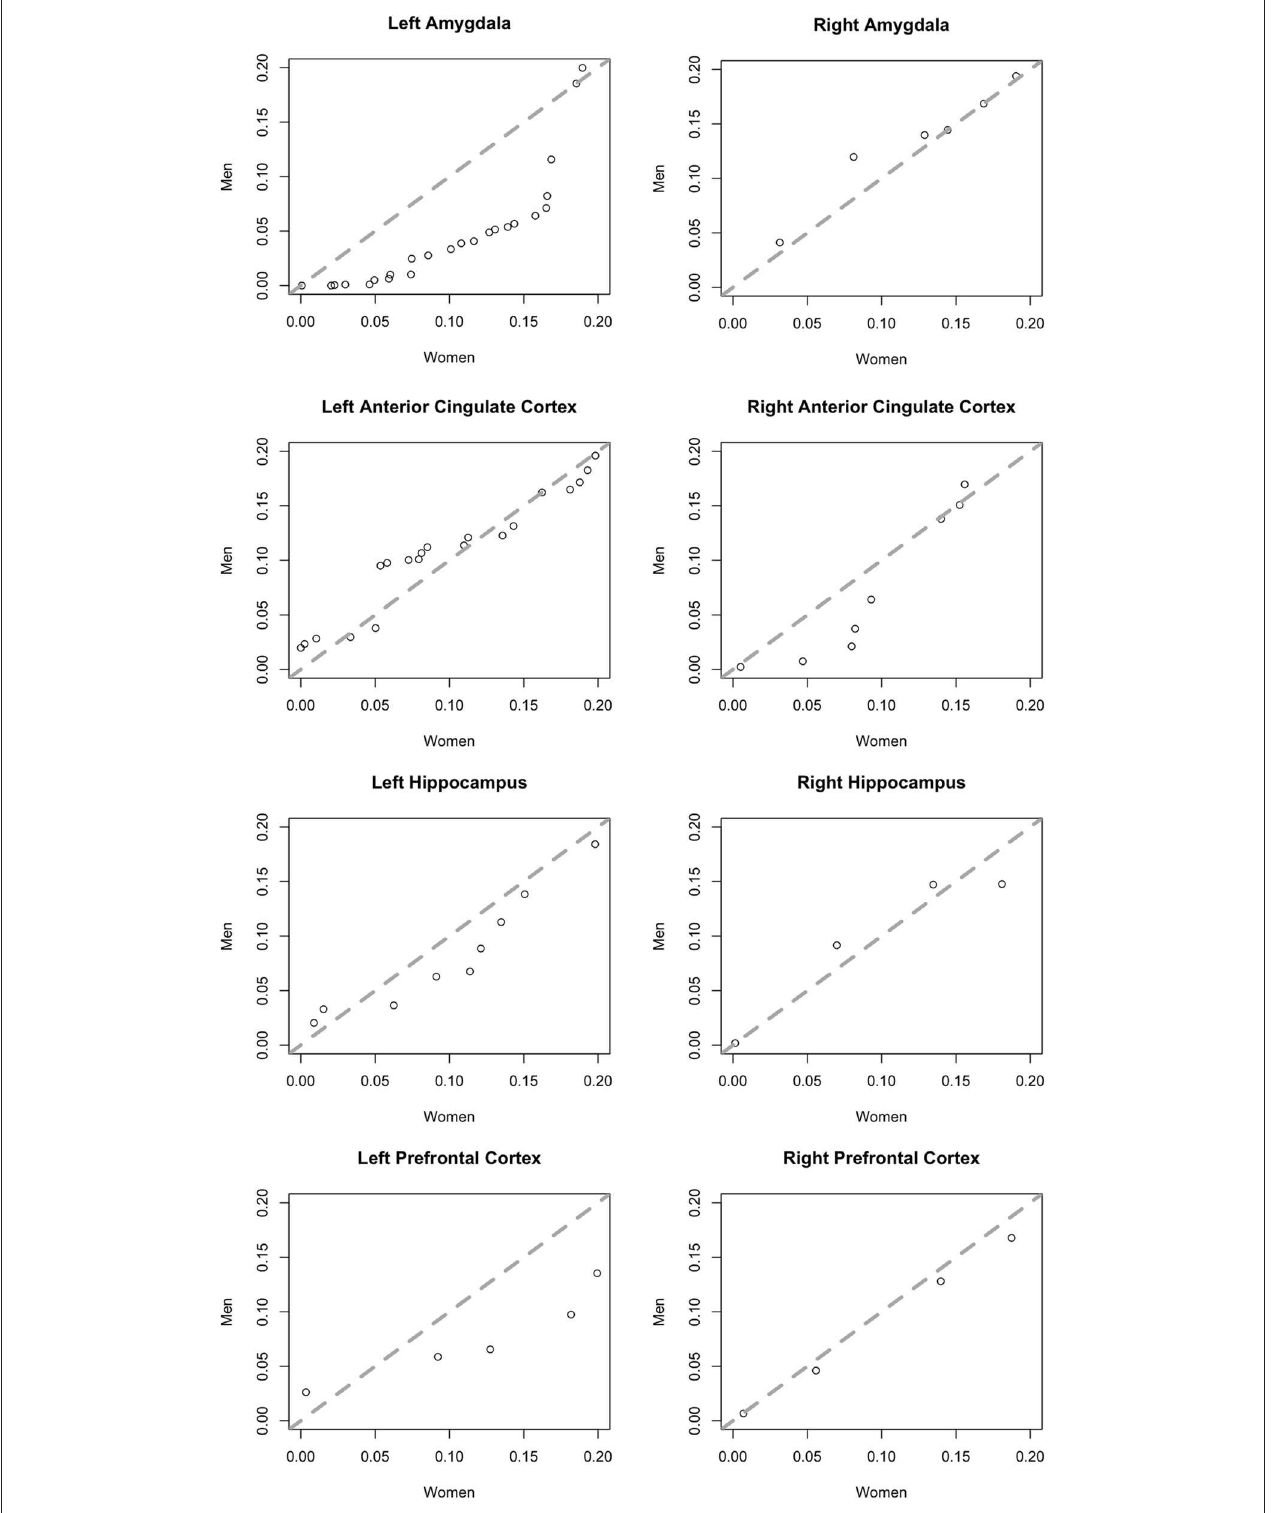
FIGURE 5 | Quantile-quantile plots of the distributions of p -values of an F-test for an effect of affect on neurons in men (y-axis) plotted against those in women (x-axis). Plots include more significant values, p < 0 . 2 . The central diagonal dashed line shows the expected result if the distributions in men and women were the